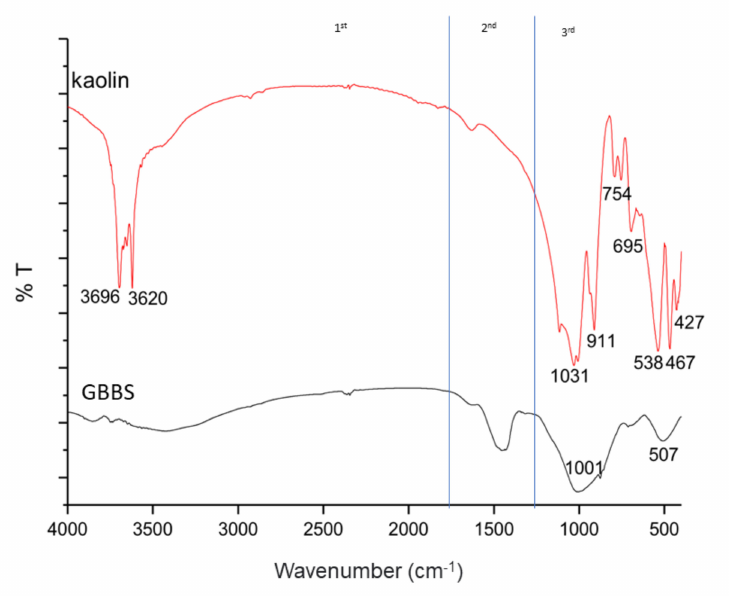
Figure 3. Fourier transform infrared spectroscopy (FTIR) spectrum of kaolin and